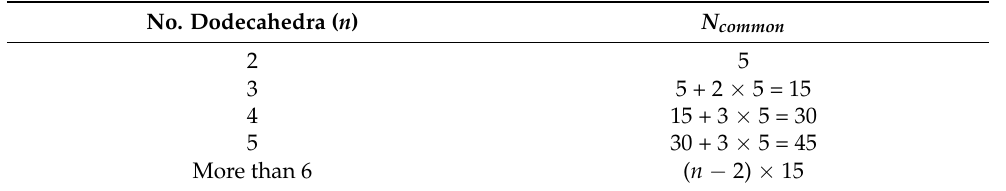
Table 2. Common vertices in structures composed of dodecahedra.